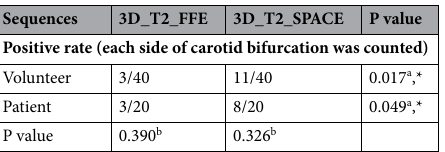
Table 3. Residual flow signal at the carotid bifurcation in the two MRI sequences. MRI, magnetic resonance imaging; FFE, fast field echo; SPACE, sampling perfection with application-optimized contrast using different